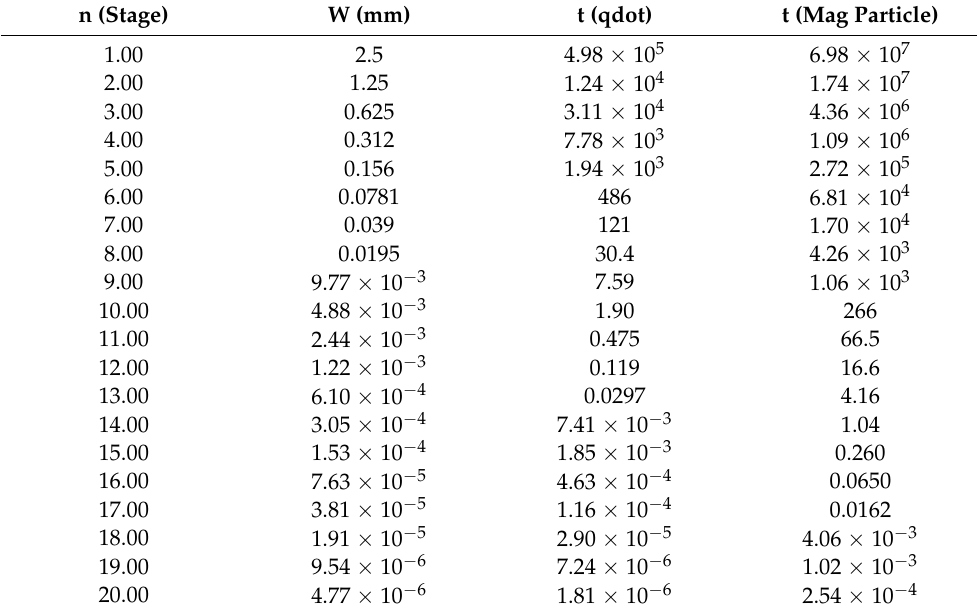
Table 2. Calculated layer width in mm and diffusion times in seconds for quantum dots t (qdot) and magnetic particles t (mag particle) as a function of mixer stage